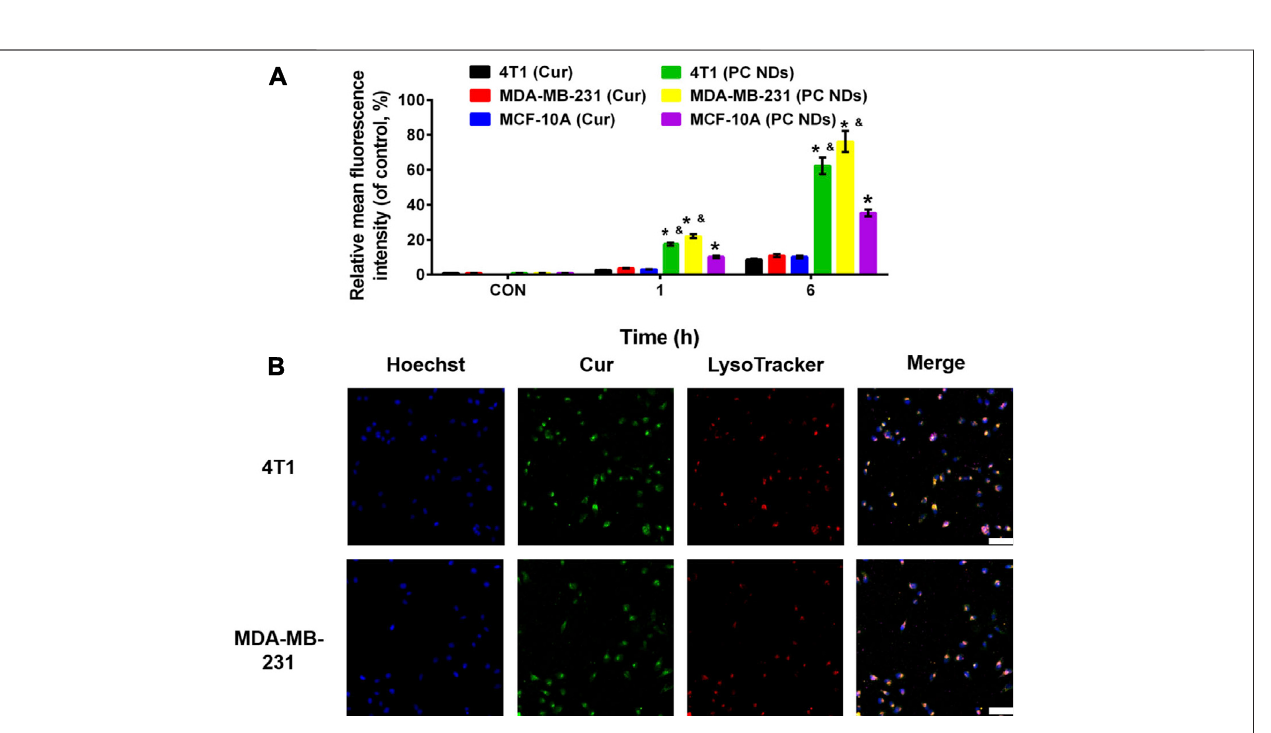
FIGURE 3 | Cellular uptake of PC NDs in 4T1, MDA-MB-231, and MCF-10A cells. (A) Quantitative analysis of the internalization of Cur and PC NDs in 4T1, MDA- MB-231, and MCF-10A cells through FACS. Statistical signi fi cance: * p < 0.05 vs control and p < 0.05 vs Cur. (B) CLSM images of 4T1 and MDA-MB-231 cells after incubation with PC NDs for 2 h. Scale bars are 200 μ